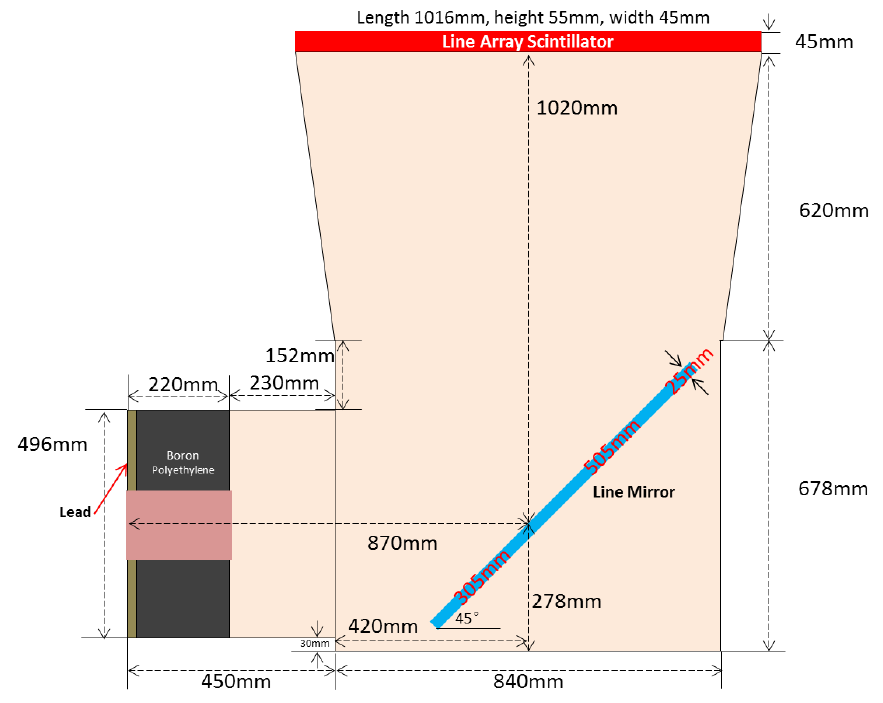
Figure 9. Overhead view of the dark case construction.